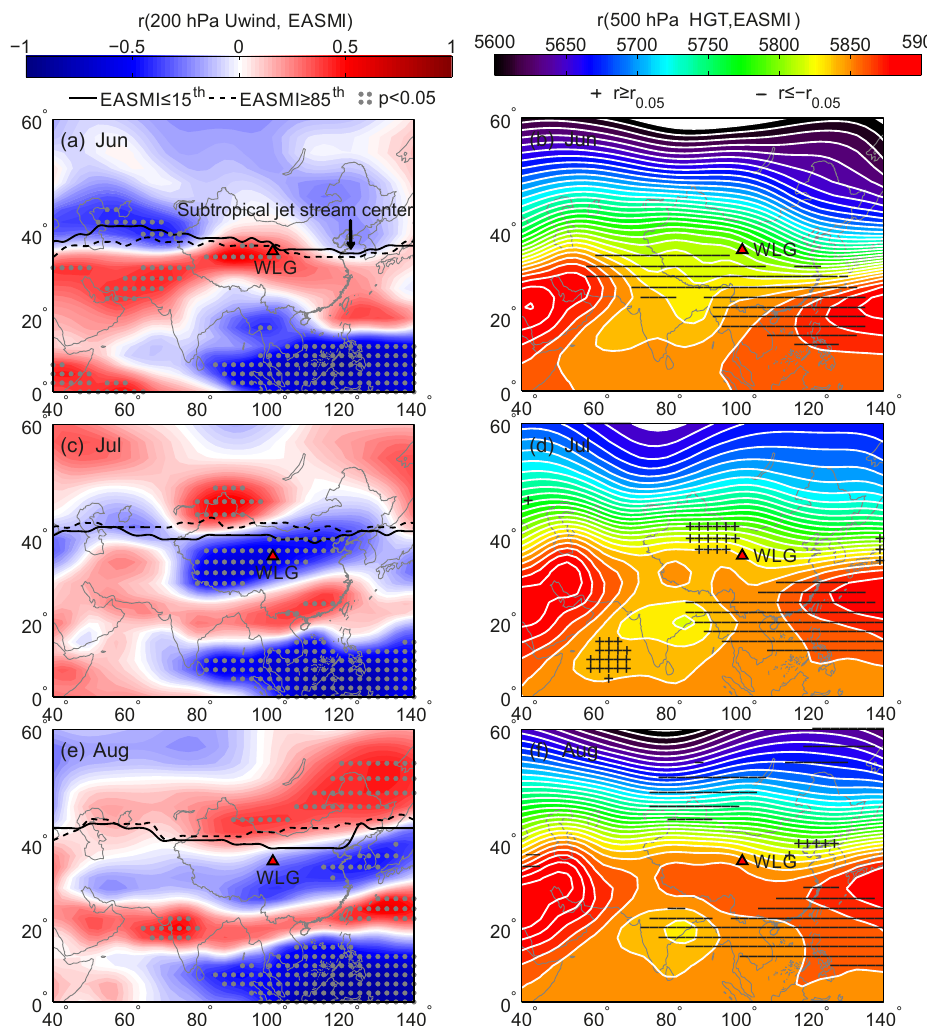
Figure 16. (a, c, e) The correlation coefficient between the 200hPa zonal wind and the EASMI and the average location of the subtropical jet stream centre for the EASMI ≤ 15th percentile and EASMI ≥ 85th percentile cases and (b, d, f) the average 500hPa geopotential height and the location of significant positive( + ) and negative( − ) correlation ( p < 0 . 05) between 500hPa geopotential height and the EASMI in (a, b) June, (c, d) July, and (e, f) August during 1990 to